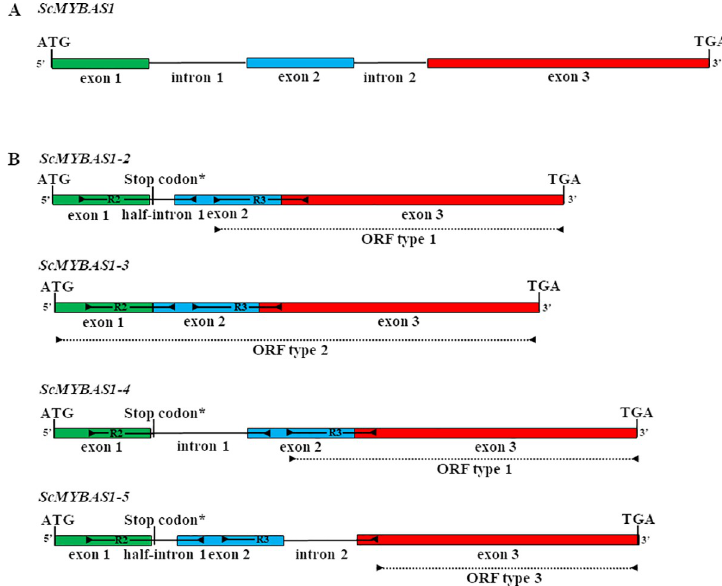
Fig 1. Schematic representation of the differently spliced transcripts of ScMYBAS1 . (A) genomic DNA containing three exons (exon 1: 122 bp; exon 2: 131 bp and exon 3: 131 bp) and two introns (intron 1: 126 bp and intron 2: 86 bp. (B) differently spliced transcripts of ScMYBAS1 , ScMYBAS1-2 (MH052202), ScMYBAS1-3 (MH052205), ScMYBAS1- 4 (MH052203) and ScMYBAS1-5 (MH052201). The start codon ‘ATG’ and stop codon ‘TGA’ of each transcript are shown. The two MYB domain repeats (R2 and R3) and putative ORFs (Type 1, 2 and 3) are indicated in differently spliced transcripts.